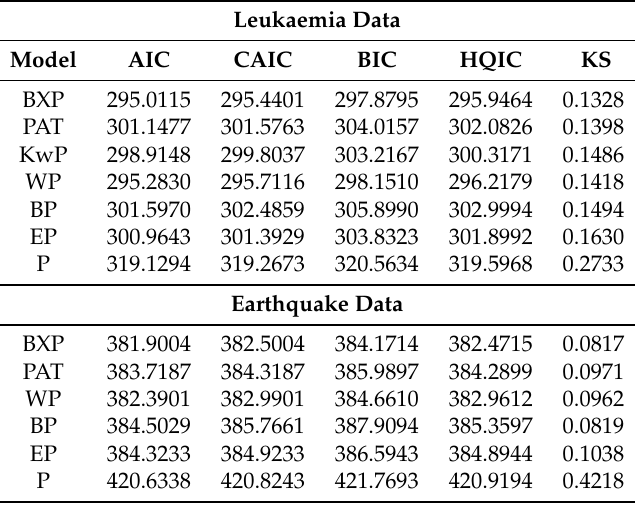
Table 4. Goodness-of-fit statistics for both datasets. CAIC, Corrected Akaike Information Criterion; HQIC, Hannan–Quinn Information